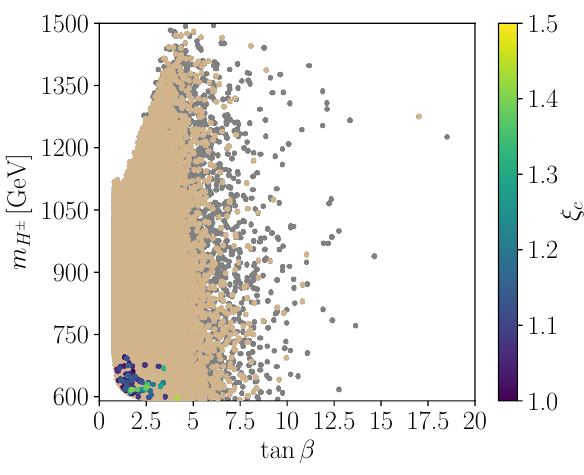
Figure 10 . N2HDM T2: the charged mass m (cid:12)gure 3. The color bar indicates the strength of the phase transition for (cid:24) c constraints are